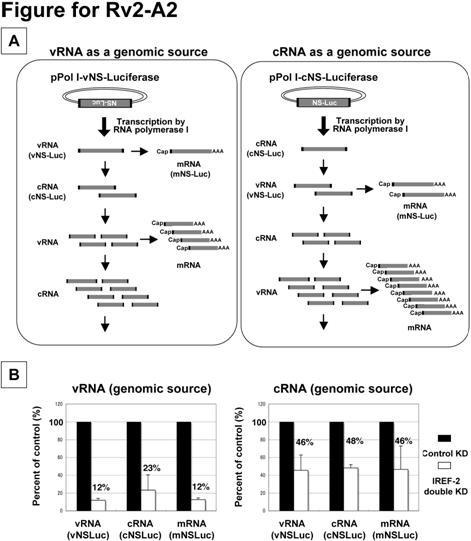
DOI:
http://dx.doi.org/10.7554/eLife.08939.013